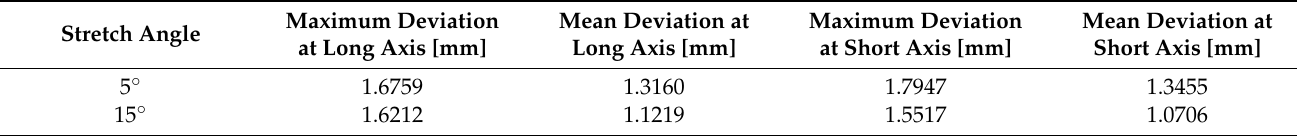
Figure 22. Z -direction deviation of the profile curves: ( a ) the section of the long axis and ( b ) the section of the short axis. Table 2. Maximum and mean